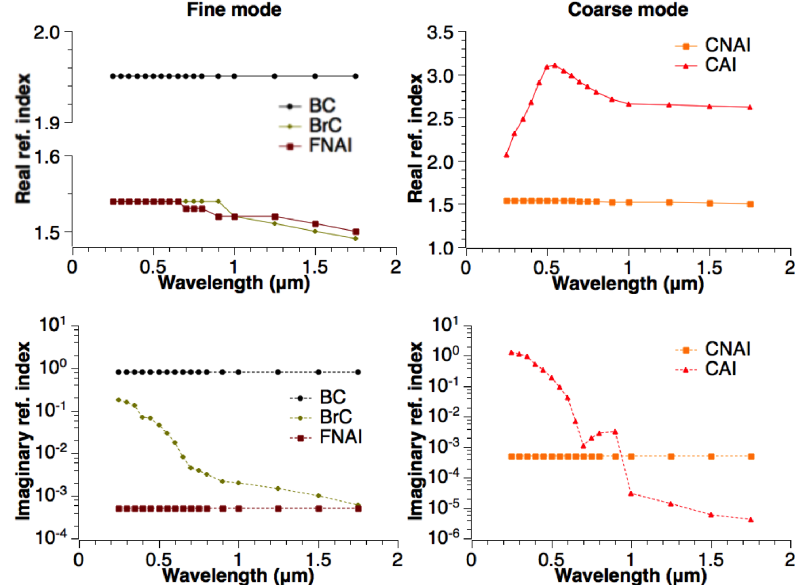
Figure 3. The refractive indices of assumed aerosol components embedded in the host of the size-dependent Maxwell Garnett conversion model. The parameters of BC refer to Bond and Bergstrom (2006). The parameters of BrC refer to Sun et al. (2007) and Schuster et al. (2016a). The parameters of fine non-absorbing insoluble (FNAI) and coarse non-absorbing insoluble (CNAI) refer to Ghosh (1999). FNAI represents dust and OC in fine-mode particles, whereas CNAI represents dust in coarse-mode particles. The parameters of coarse absorbing insoluble (CAI) refer to Longtin et al. (1988) representing hematite.